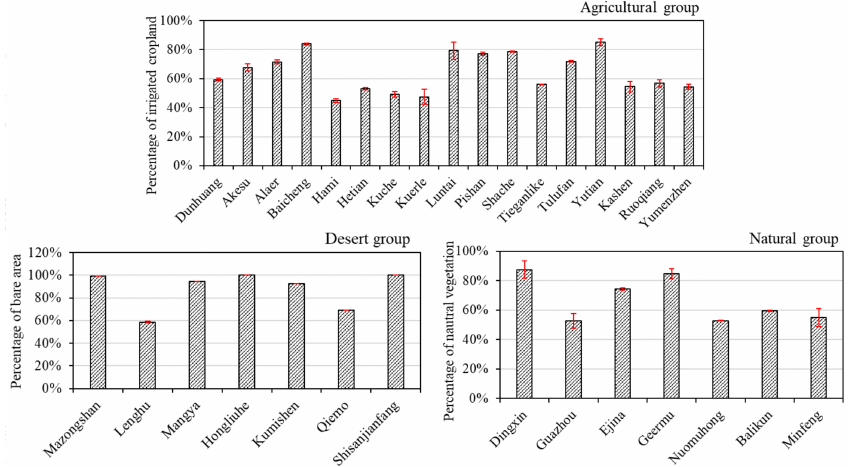
Figure 3. Annual mean values and standard deviations of percentage of dominant land cover at stations in different groups from 1992 to